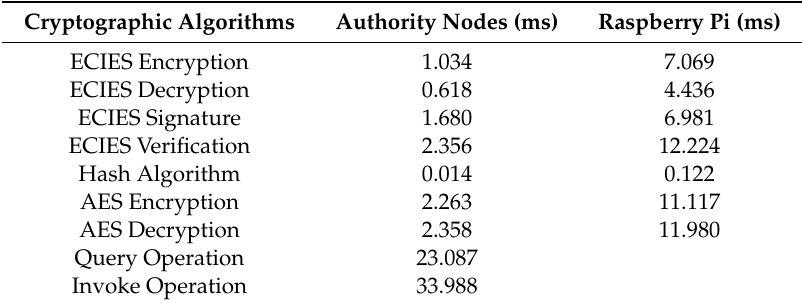
Table 2. Time consumption for the cryptographic algorithms.